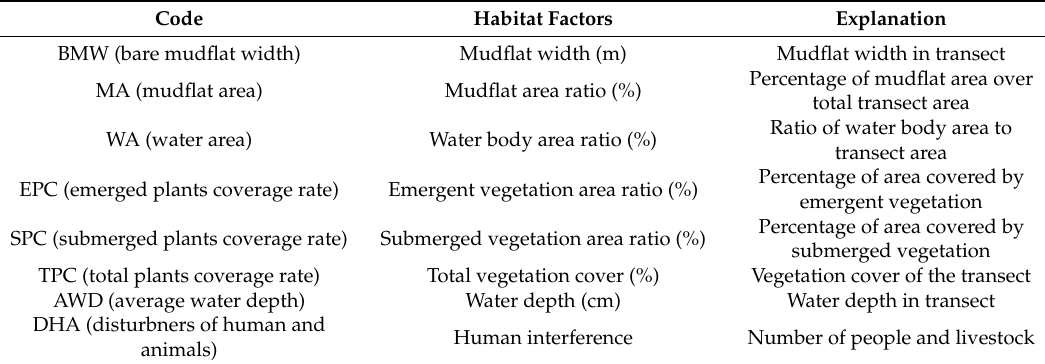
Table 1. The parameters of the habitat factors in three